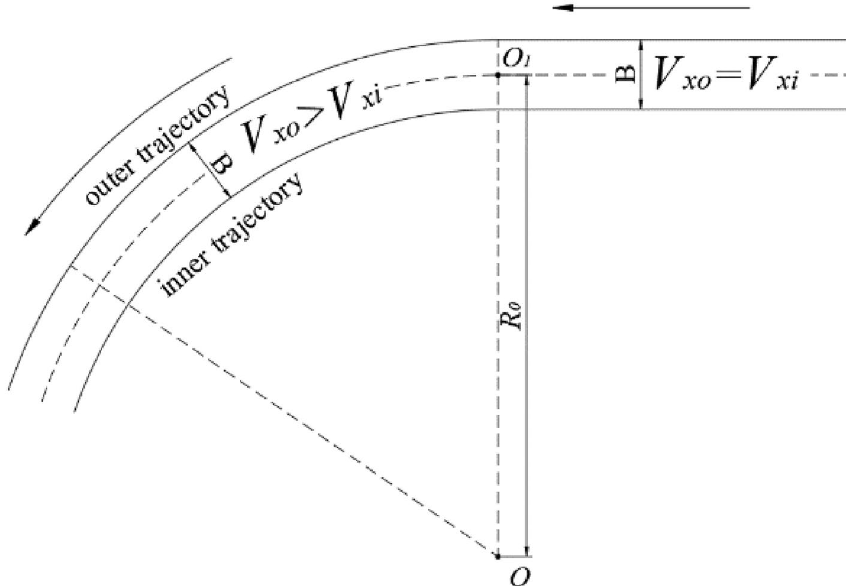
Figure 4. An ideal trajectory of the four wheels during the experiment.